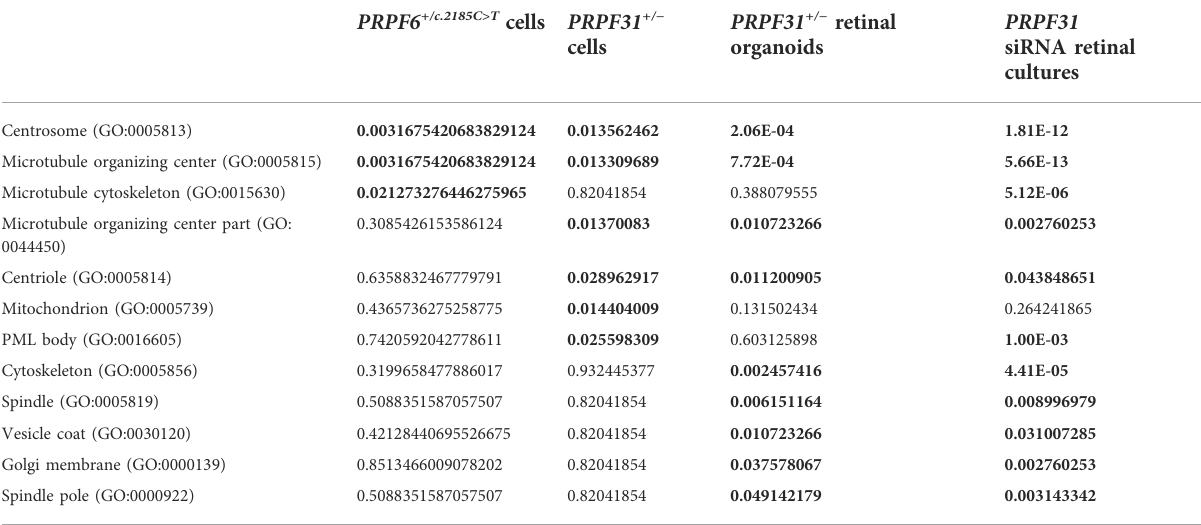
TABLE1FDRadjusted p valuesfromgeneontologyenrichmentanalysisofdifferentiallysplicedexonsinPRPF6baseeditedcells,PRPF31editedcells, PRPF31 +/ − patient-derived retinal organoids and PRPF31 siRNA-treated retinal cultures. Statistically signi fi cantly enriched GO terms and their FDR-adjusted p values are highlighted in bold.